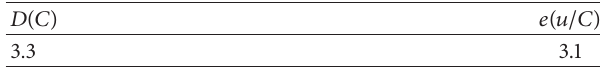
Table 1: Simulation parameters. Table 2: Algorithm clusters